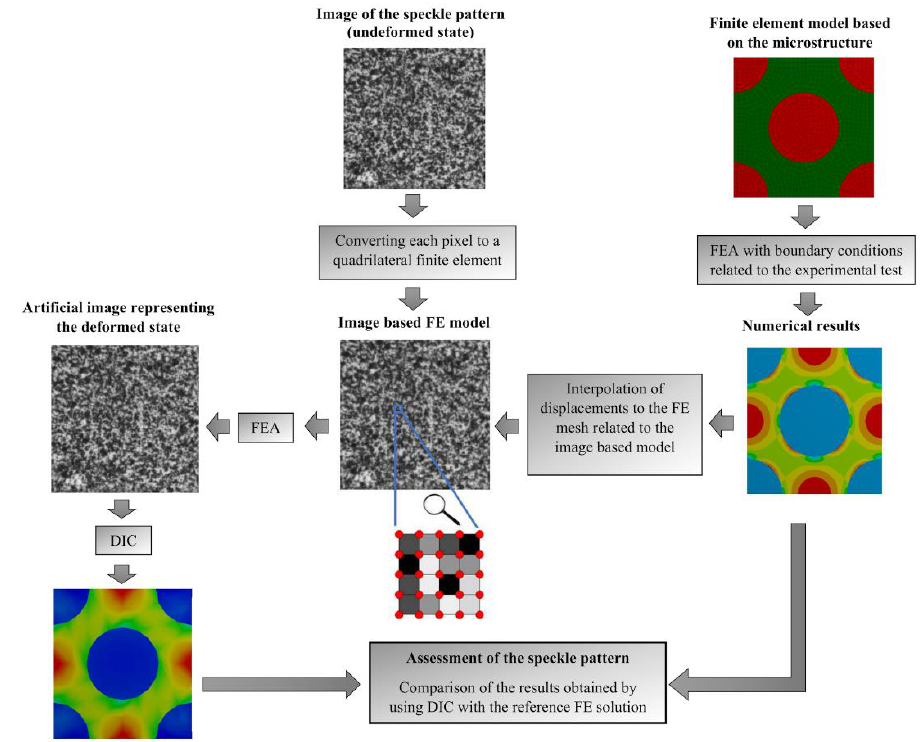
Figure 1. Flowchart of the method of the DIC measurement accuracy.